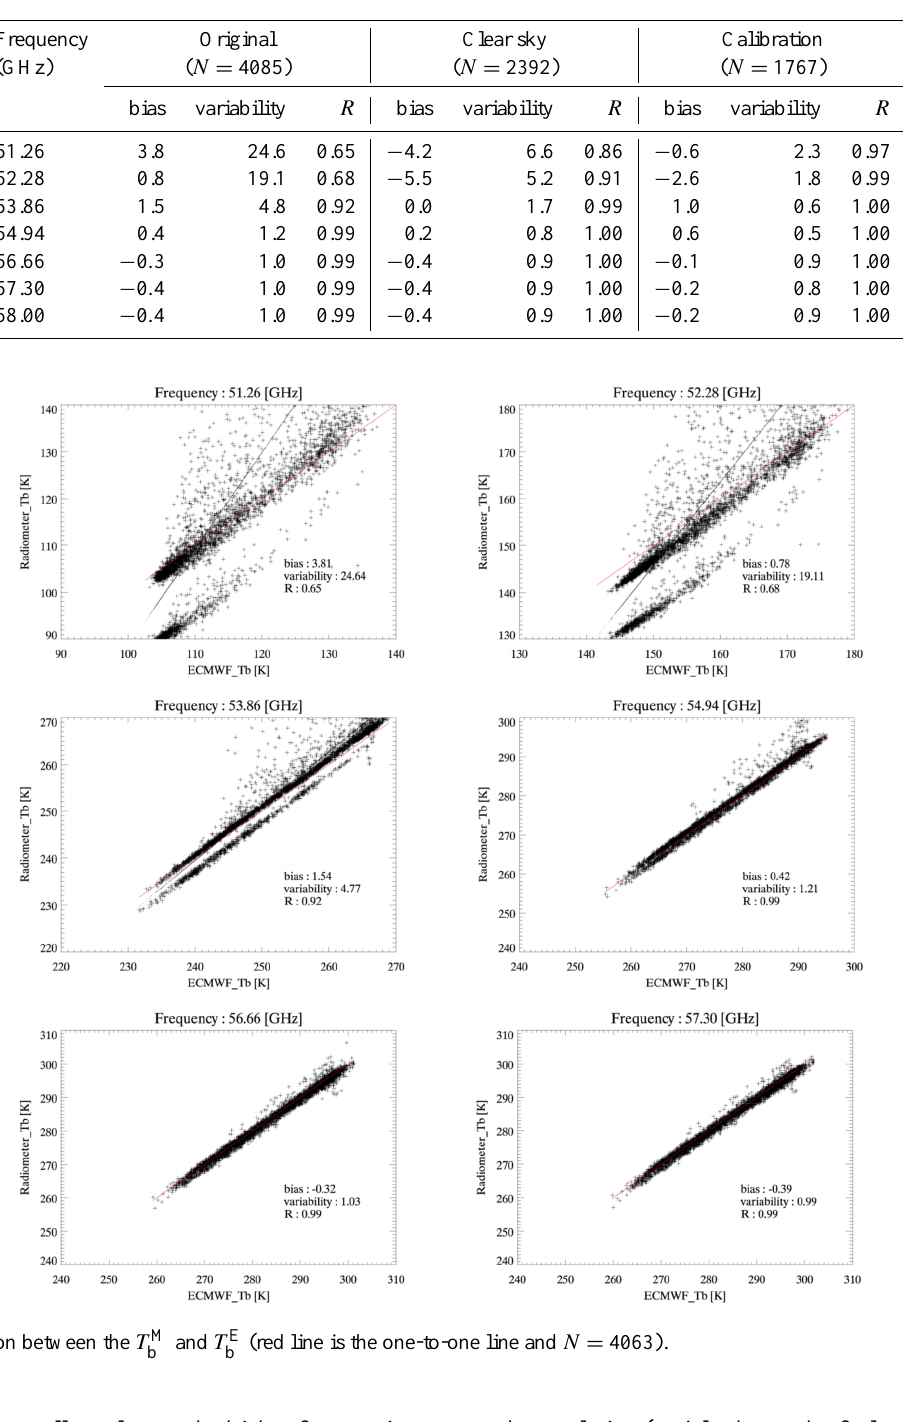
channel with much smaller values at the higher